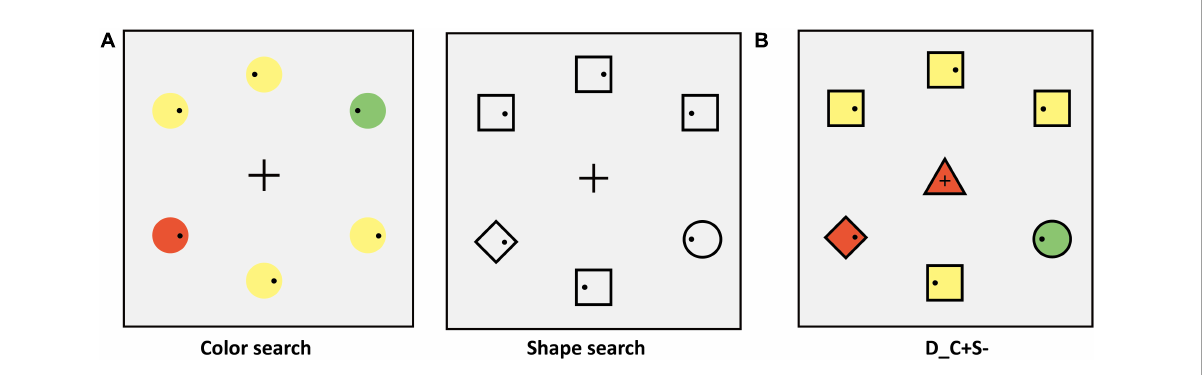
FIGURE5 (A) Schematic search display of the matching phase (e.g., target: green circle). The schematic procedure of the matching phase is shown in Figure 3 . (B) Schematic one of the center stimuli conditions, the other conditions were the same as in Experiment 1A. The schematic procedure of the search task phase was similar to that in Experiment 1A, except that the color of